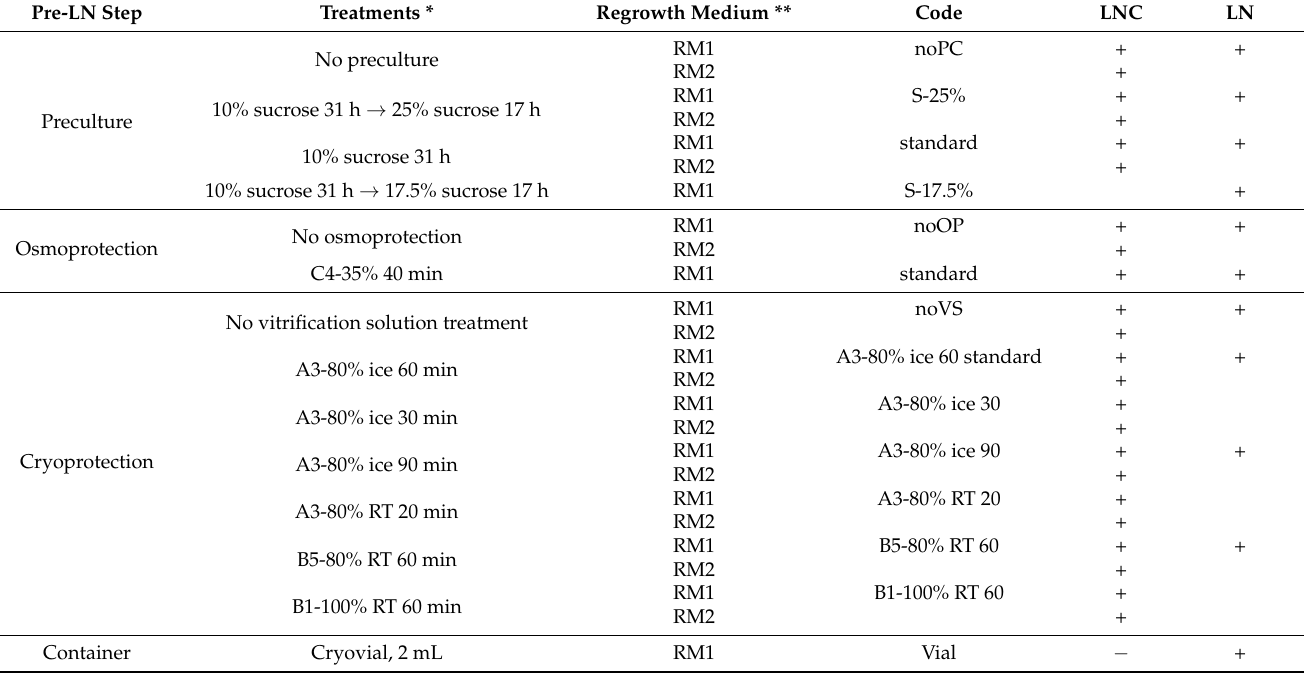
* Composition of cryoprotectant solutions is given in Table 5; RT—room temperature, 25 ± 1 ◦ C; ice—treatment performed on the ice bath at 0 ◦ C. ** Regrowth medium used during the first 5 days after rewarming (step 1 of the three-step standard regrowth procedure).